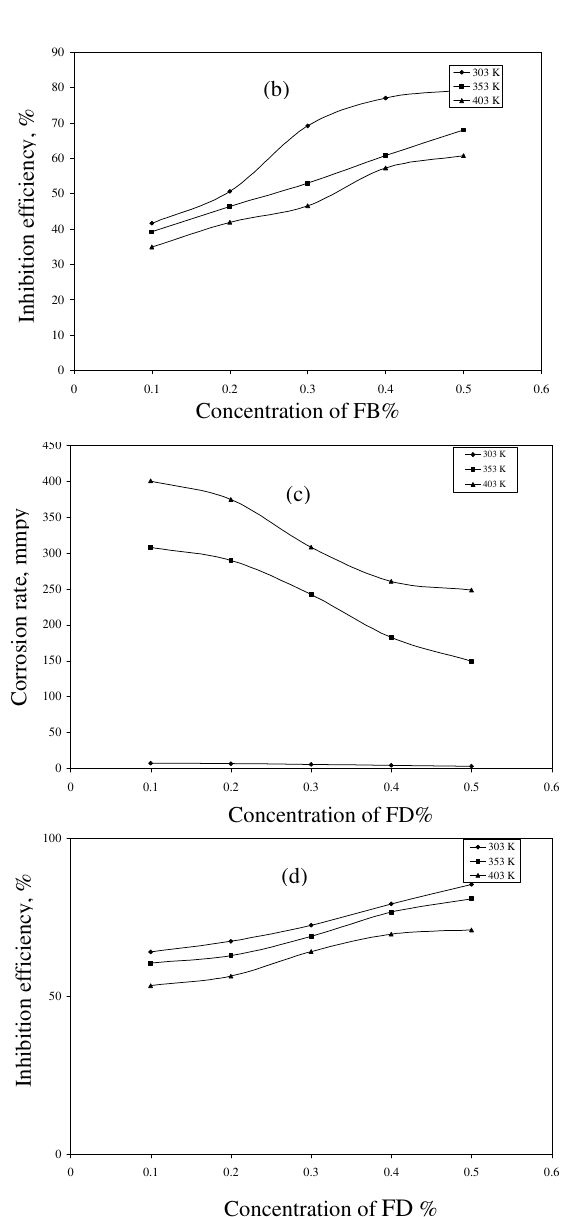
Figure 1 (a) Variation of corrosion rate (CR) with concentration of FB (in %) in HCl solution at different temperature, (b). Variation of inhibition efficiency (IE) with concentration of FB (in %) in HCl solution at different temperature, (c). Variation of corrosion rate (CR) with concentration of FD (in %) in HCl solution at different temperature, (d). Variation of inhibition efficiency (IE) with concentration of FD (in %) in HCl solution at different